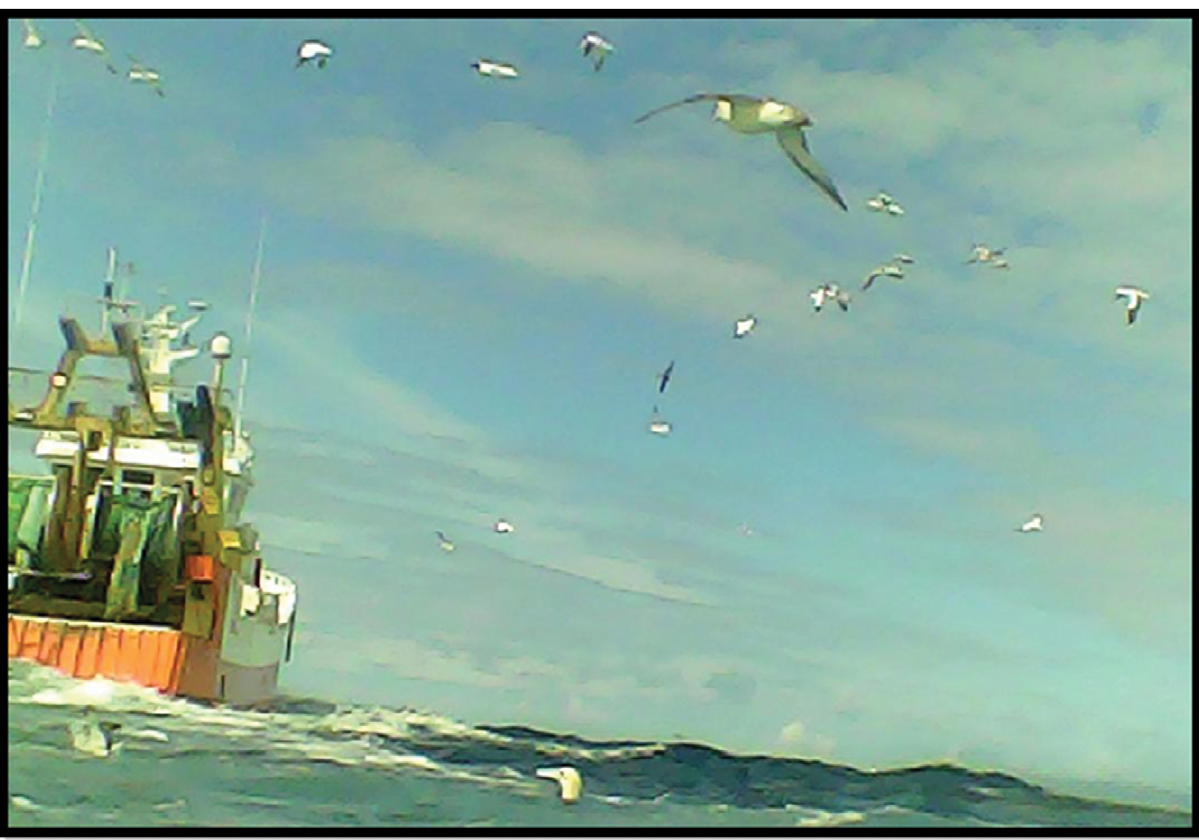
Figure 1. Bird-borne cameras reveal seabird/fishery interactions. All tracked gannets photographed fishing vessels, often in the company of large groups of other scavengers.